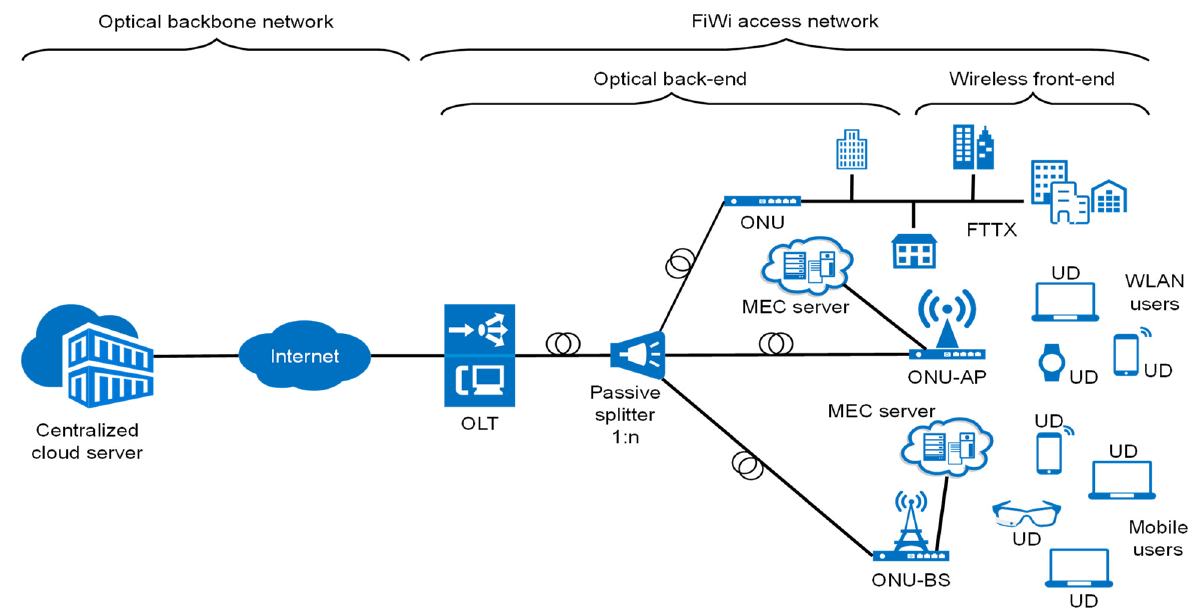
Figure 10. The generic architecture of a CM-FiWi access network.